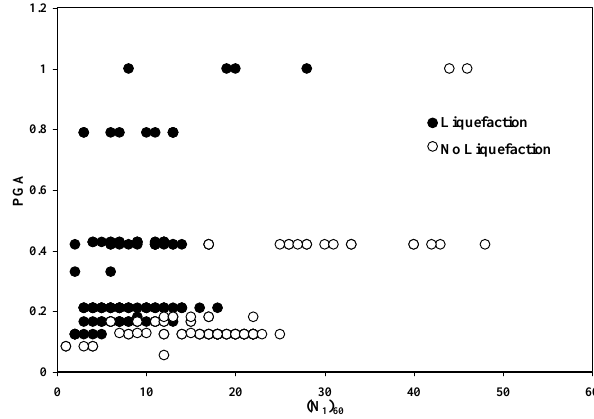
Fig. 4. Plot between CSR and (N 1 ) 60 for MODEL I using training Figure 4. Plot between CSR and (N 1 ) 60 for MODEL I using training dataset for ANN dataset for ANN model. model.